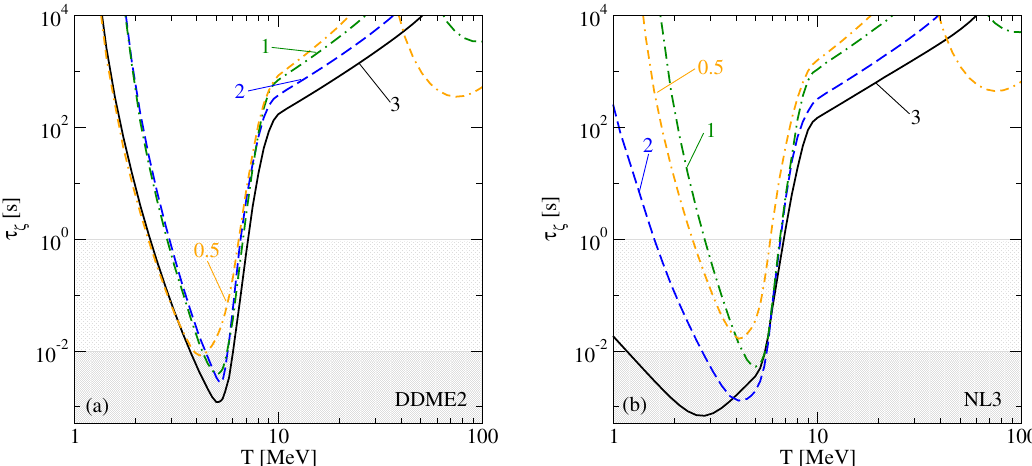
Figure 8. The oscillation damping timescale as a function of temperature for various densities and for frequency fixed at f = 1 kHz. We interpolate between the neutrino-transparent and neutrino-trapped regime, as in Figure 6; ( a ) model DDME2; ( b ) model